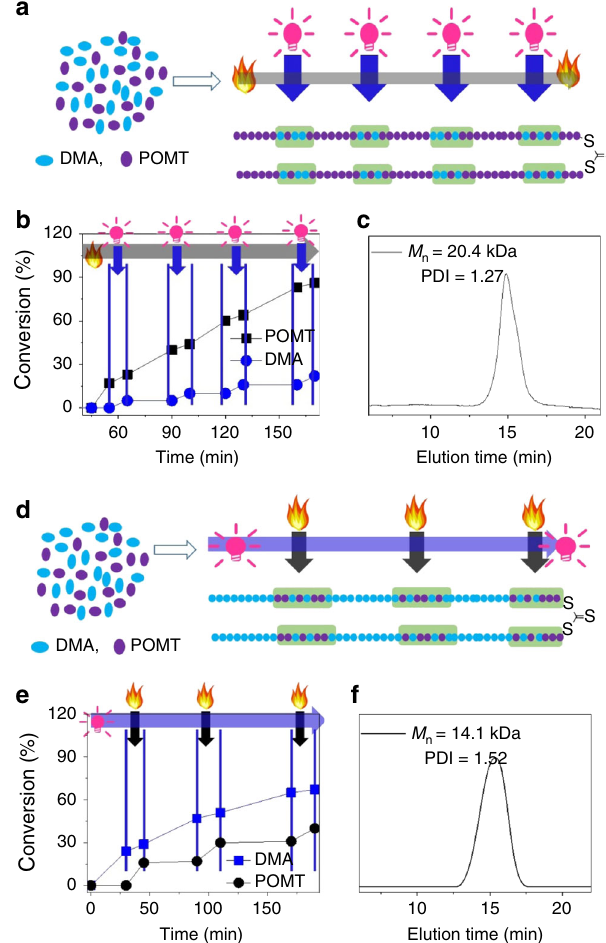
Fig. 6 Synthesis of copolymers with controlled sequence structures. a Scheme of synthesis of copolymers with controlled sequence structures via continuous heating combined with intermittent irradiation. b Monomer conversion vs. polymerization time under continuous heating combined with intermittent irradiation. c SEC curve of a typical resulting copolymer with a controlled sequence structure formed via continuous heating combined with intermittent irradiation. d Scheme of synthesis of copolymer with controlled sequence structures via continuous irradiation combined with intermittent heating. e Monomer conversion vs. polymerization